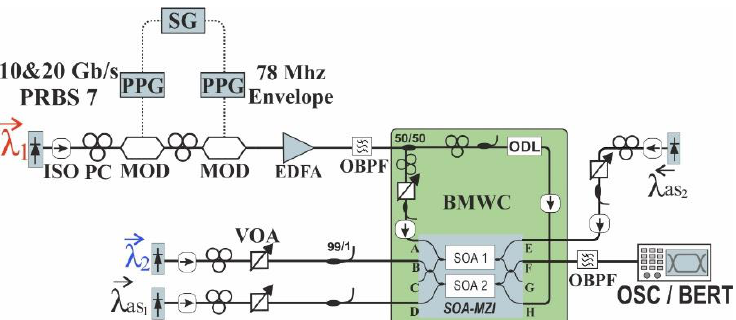
Figure 1. Experimental setup for testing the proof of concept of the Burst-Mode Wavelength Converter (BMWC). EDFA: Erbium Doped Fiber Amplifier; ISO: Isolators; MZI: Mach Zehnder Interferometer; OBPF: Optical Bandpass Filter; PC: Polarization Controllers; PPG: Programmable Pattern Generators; PRBS: Pseudo Random Bit Sequences; SOA: Semiconductor Optical Amplifier; VOA: Variable Optical Attenuators.